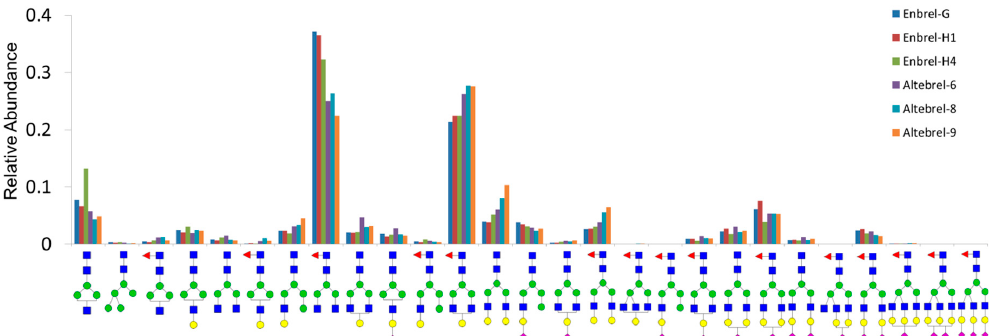
Figure 3. Relative quantities of the N-glycans according to area under the curve of their XICs.